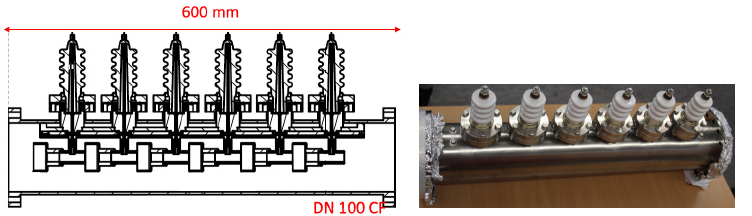
Figure 9. Schematic diagram and photo of the vacuum pipe and high-voltage feedthroughs of the post-stage linac.